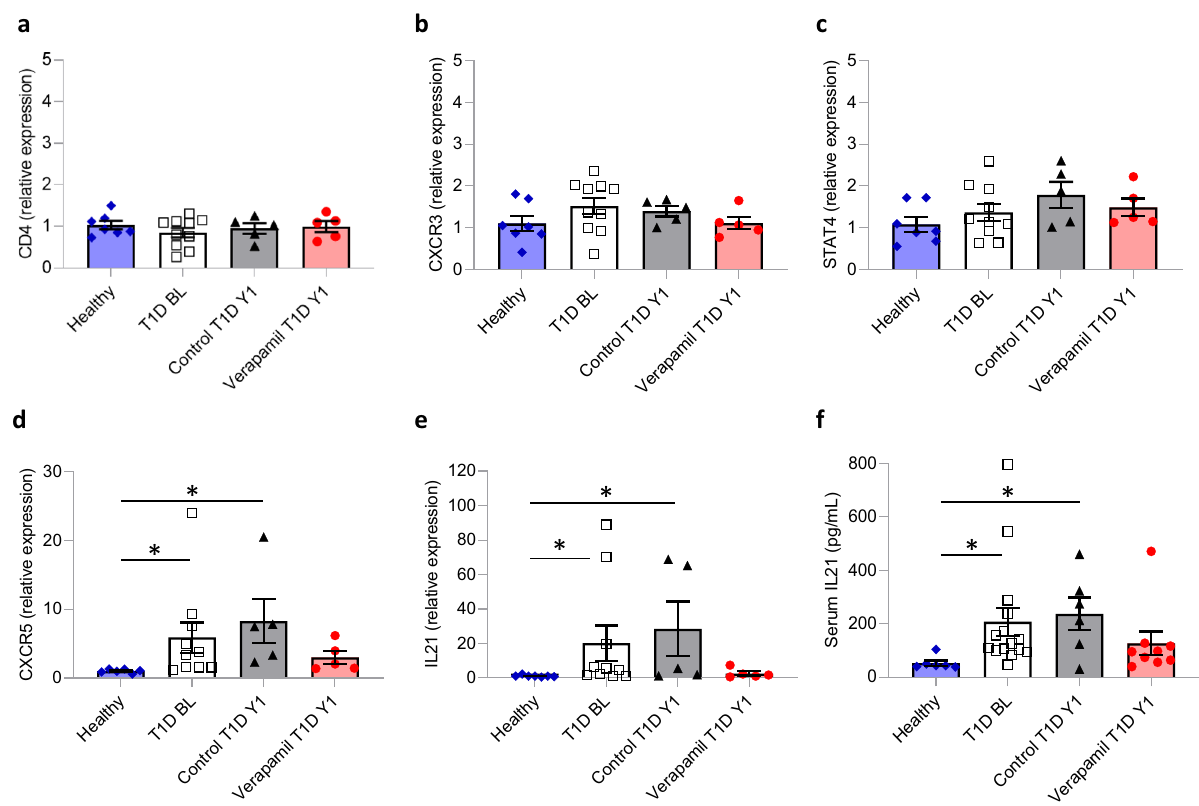
Fig. 3 Effects of T1D and verapamil treatment on T-cells. Expression of the T-cell markers CD4 (NS) ( a ), CXCR3 (NS) ( b ), STAT4 (NS) ( c ), CXCR5 ( H 3 = 14.011, * P = 0.003) ( d ) and IL21 ( H 3 = 11.516, * P = 0.009) ( e ) as assessed by qPCR in PBMCs from healthy, non-diabetic volunteers (blue) ( n = 7), subjects with T1D at baseline (T1D BL) (white) ( n = 10), subjects with T1D getting placebo for 1 year (Control T1D Y1) (grey) ( n = 5) or receiving verapamil for 1 year (Verapamil T1D Y1) (red) ( n = 5). Serum levels of the proin fl ammatory cytokine IL-21 as assessed by ELISA ( H 3 = 11.847, * P = 0.008) ( f ). Bars represent means± SEM; Kruskal-Wallis (nonparametric ANOVA) and Dunn ’ s multiple comparisons. Source data are provided as a Source Data fi